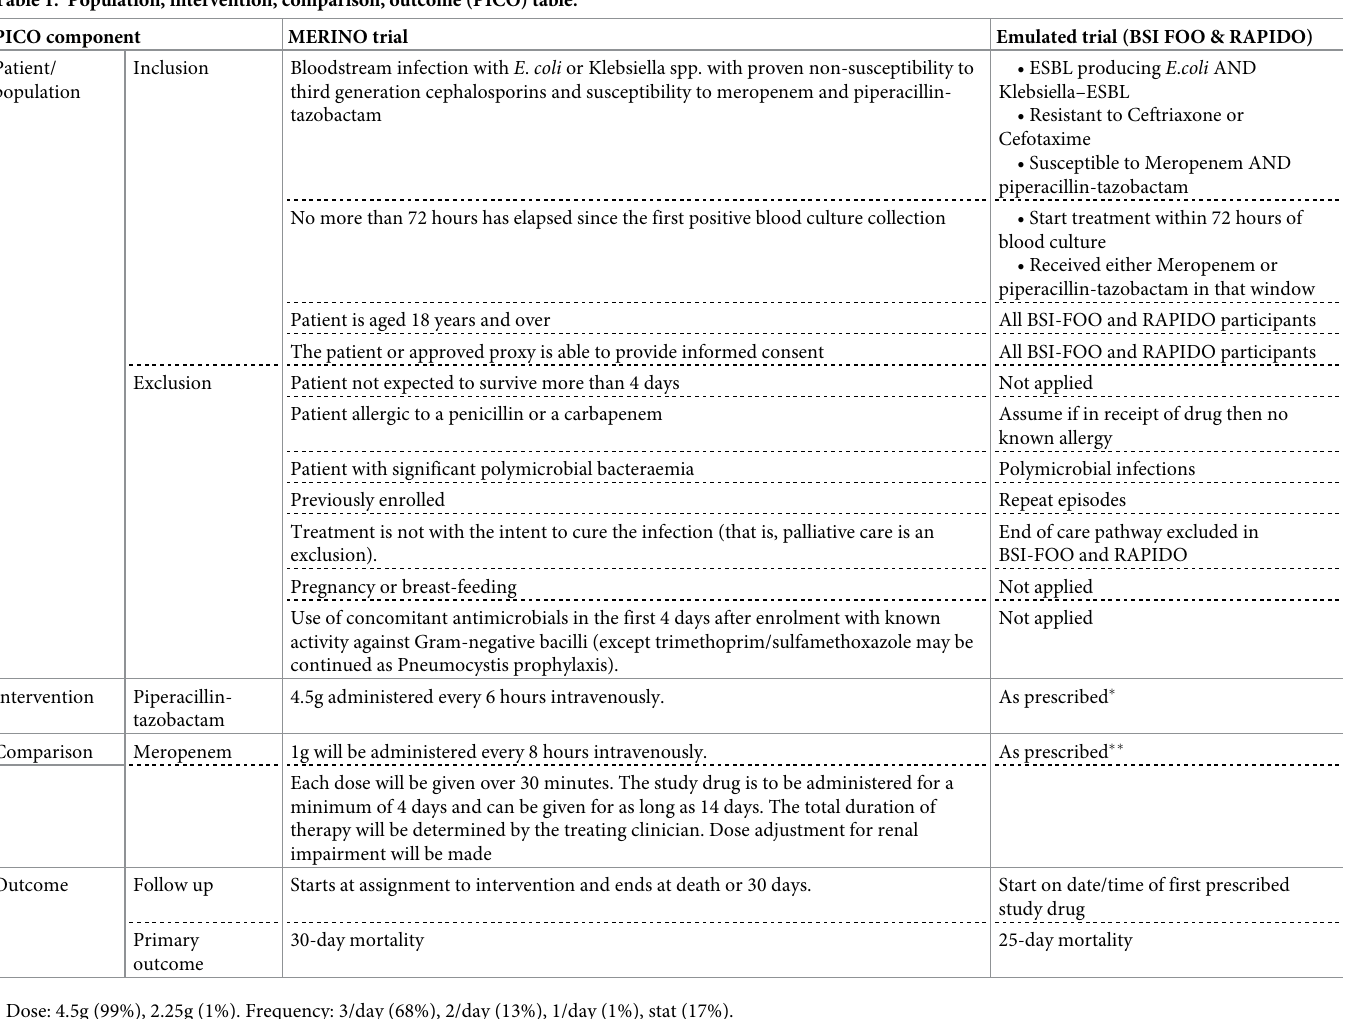
Table 1. Population, intervention, comparison, outcome (PICO) table. PICO